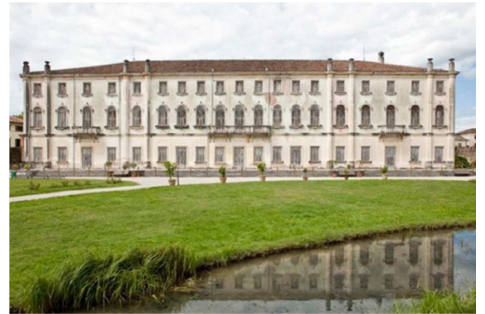
Figure 2: View of the “summer” wing of Villa Bolasco.